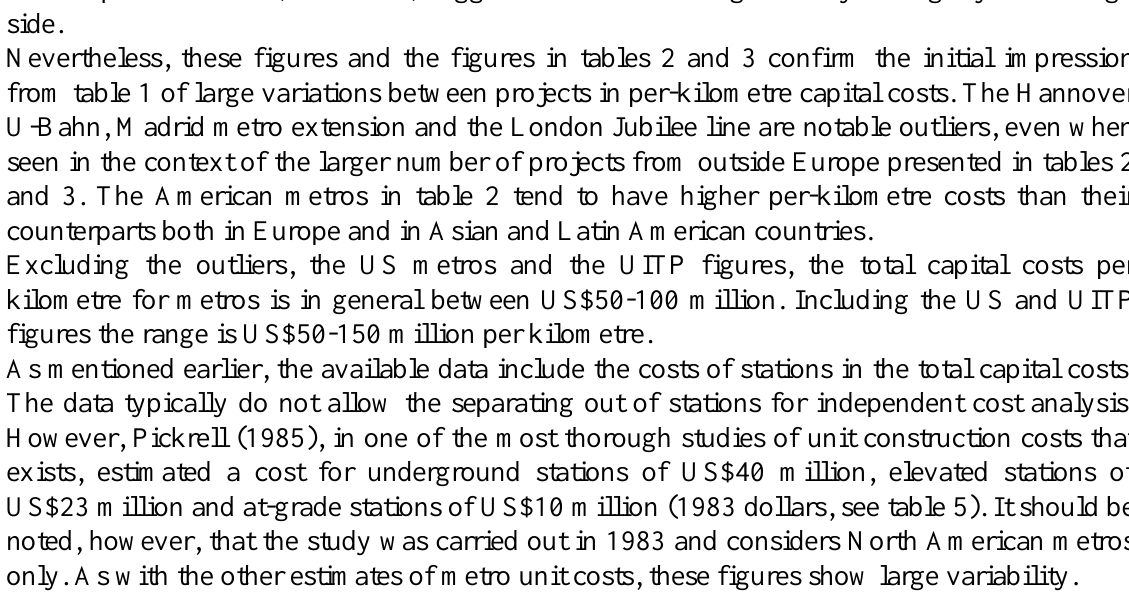
Table 5. Estimates of unit construction costs relating to